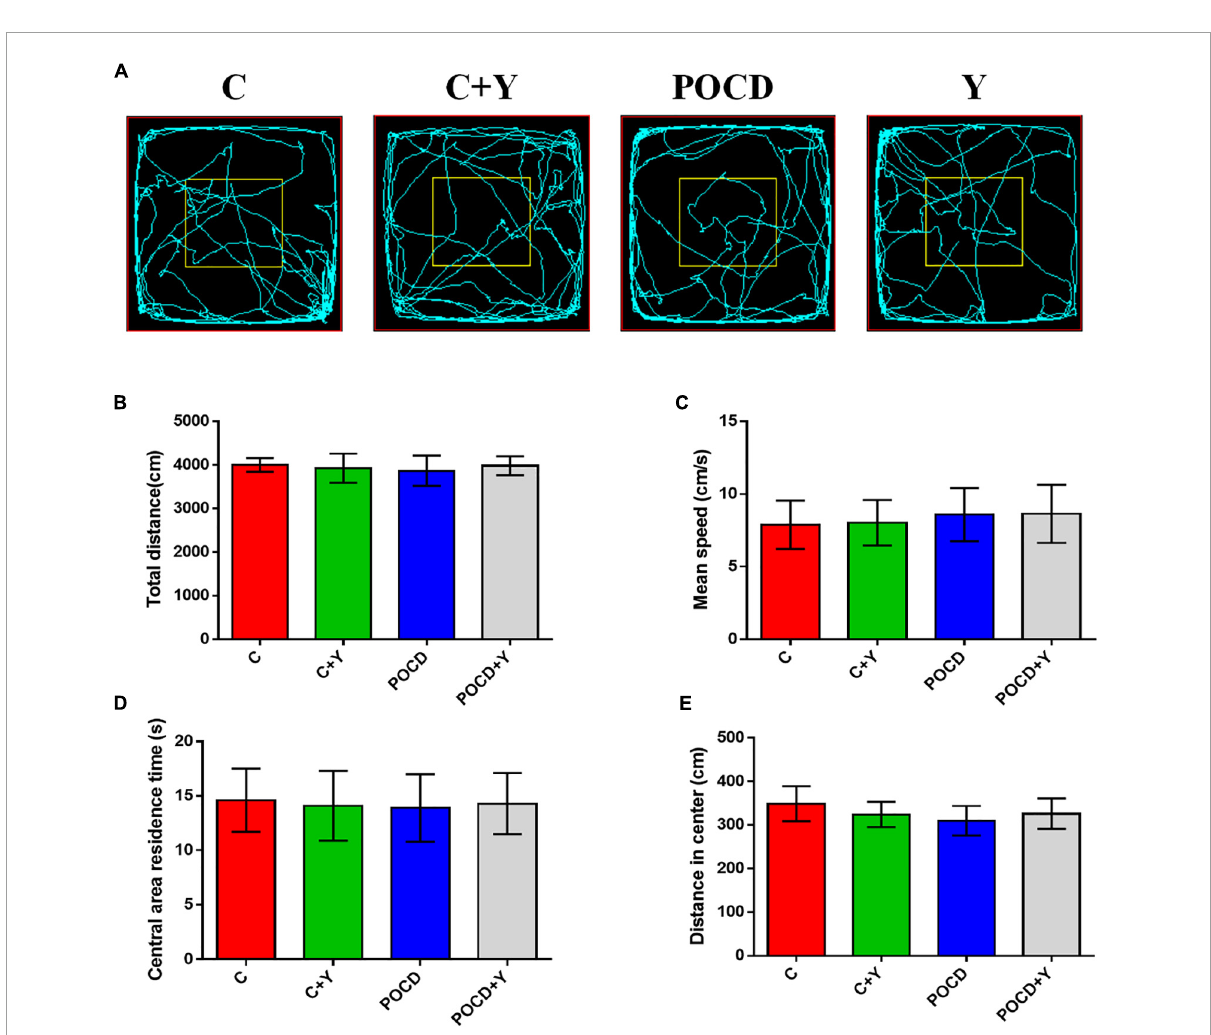
FIGURE3 Anesthesia and surgery had no effect on the spontaneous activity of the aged rats. (A) Traveling trajectory in the open field. (B) Total distance traveled. (C) Mean traveling speed. (D) Central area residence time. (E) Traveling distance in the center of the open field.